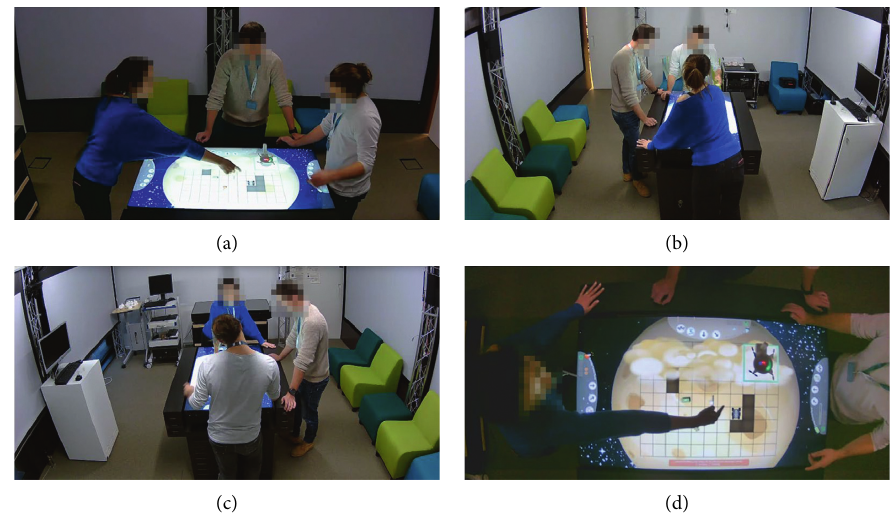
Figure 5: The problem-solving process of each group was recorded using four fixed cameras (top, front, left, and right angles).